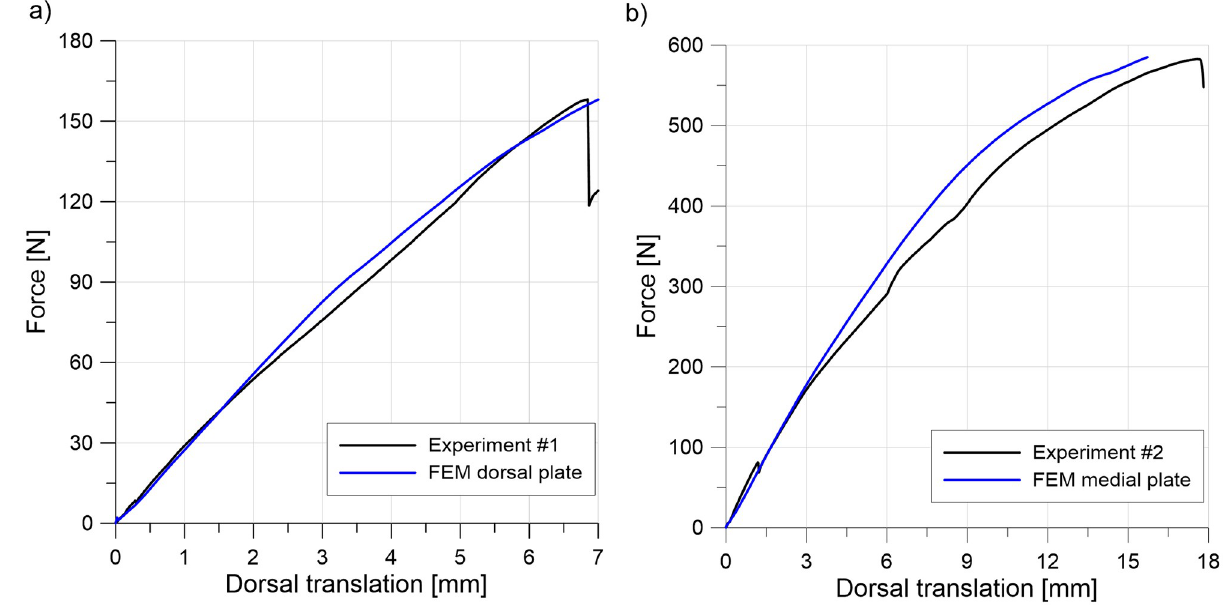
Fig 6. Validation of the model force-displacement curves for a) a dorsally positioned plate and b) a medially positioned plate.